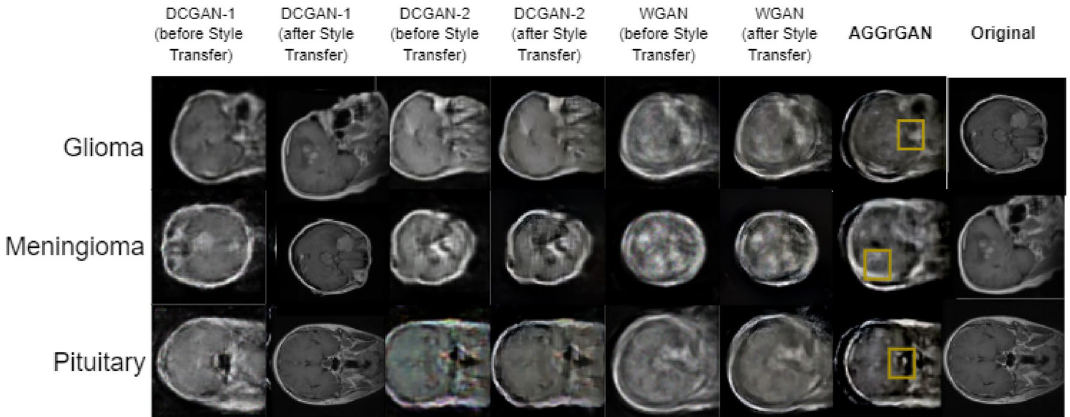
Figure 3. Sample generated images in the brain tumor dataset 34 where each row represents images of the same class and each of the six leftmost columns represents images generated by the same method (tumor region produced by the AGGrGAN model is marked) and the rightmost column represents the original images.